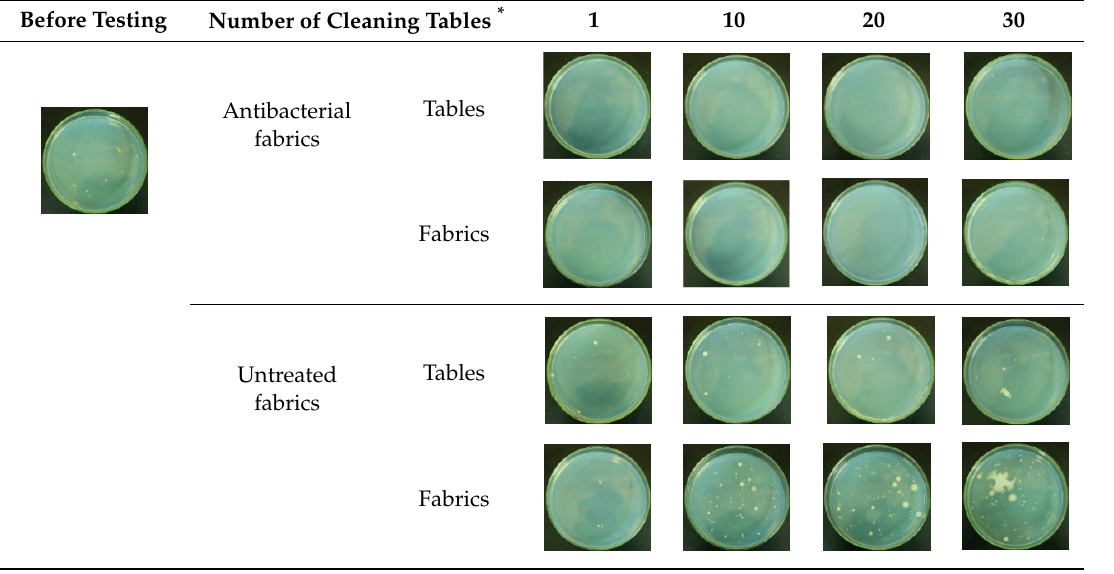
Table 1. The antibacterial qualitative testing results of chlorinated fabrics.